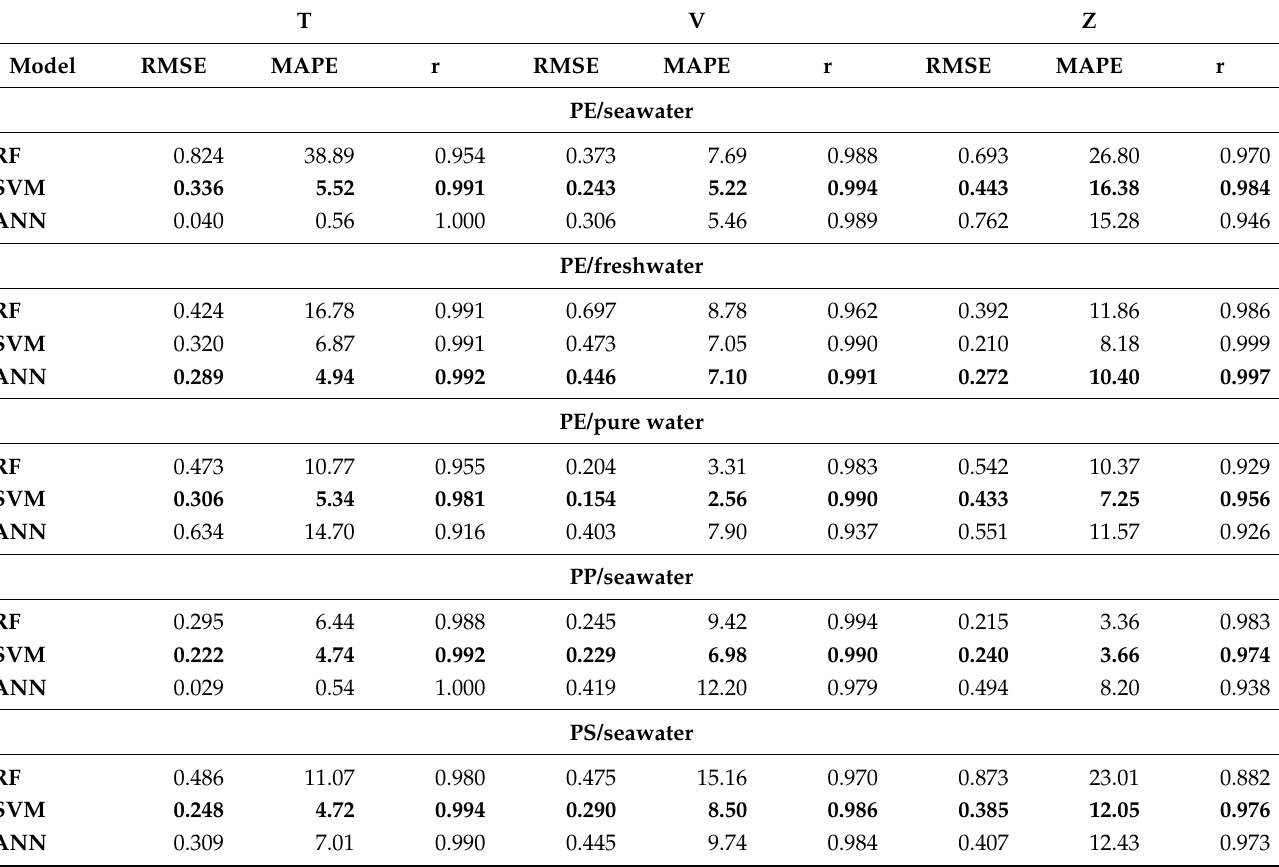
Table 3. Adjustments for the different machine learning models developed using the input variables selection Type 2. RMSE is the root mean square error, MAPE corresponds to the mean absolute percentage error, and r is the correlation coefficient. RF is the random forest model, SVM is the support vector machine model, and ANN corresponds to the artificial neural network model. T, V, and Q are the training, validation, and query phases, respectively. The best models (regarding RMSE for the validation phase) are in